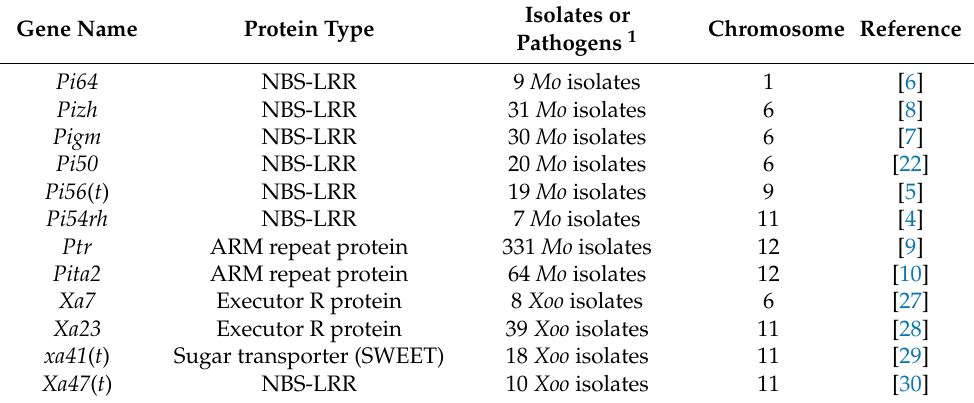
Table 1. R genes with broad-spectrum disease resistance in rice reported in past 10 years.